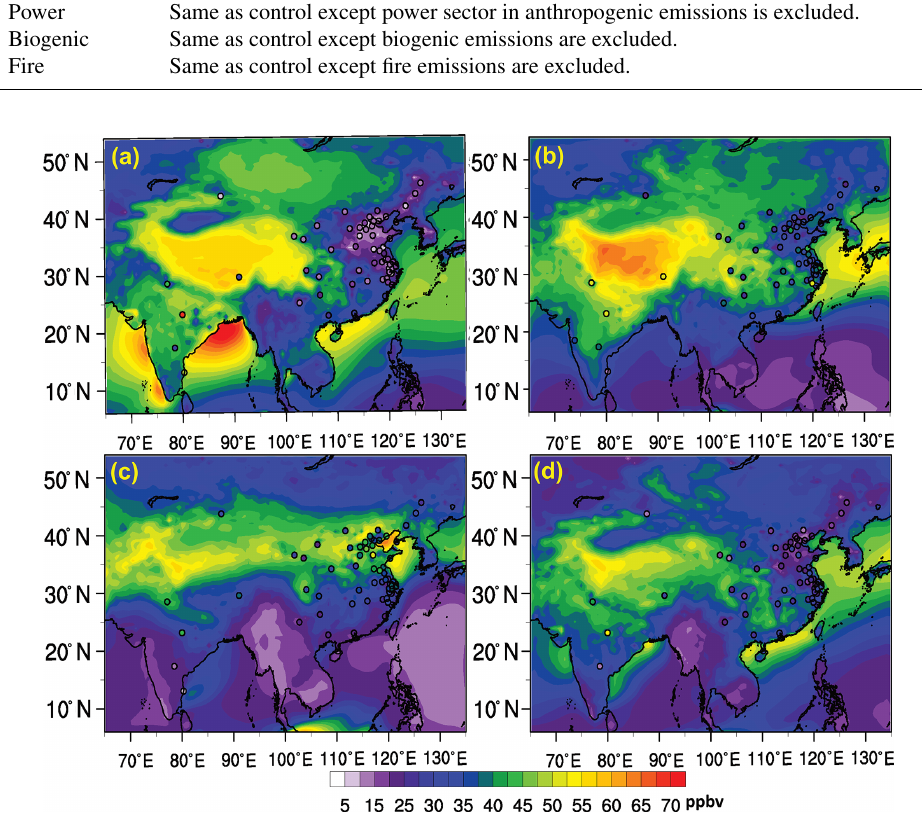
Figure 2. Spatial distribution of simulated and observed seasonal mean ozone concentrations for winter (a) , spring (b) , summer (c) , and autumn (d)